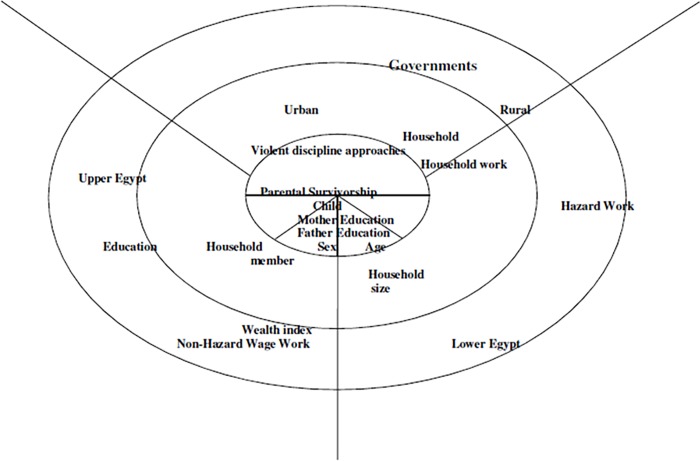
A multilevel risk factors of child labour that applied in this study.